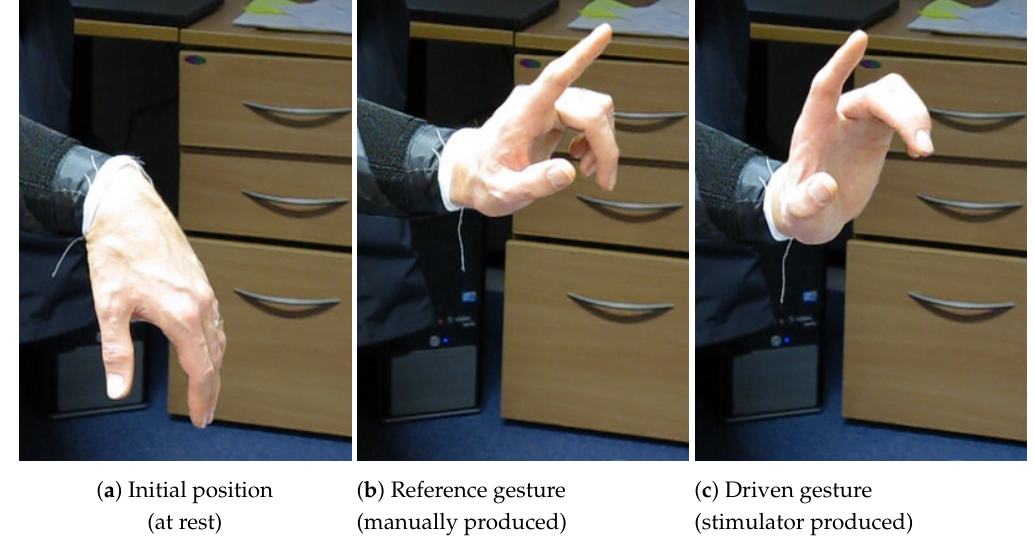
Figure 9. Photographs showing target and produced